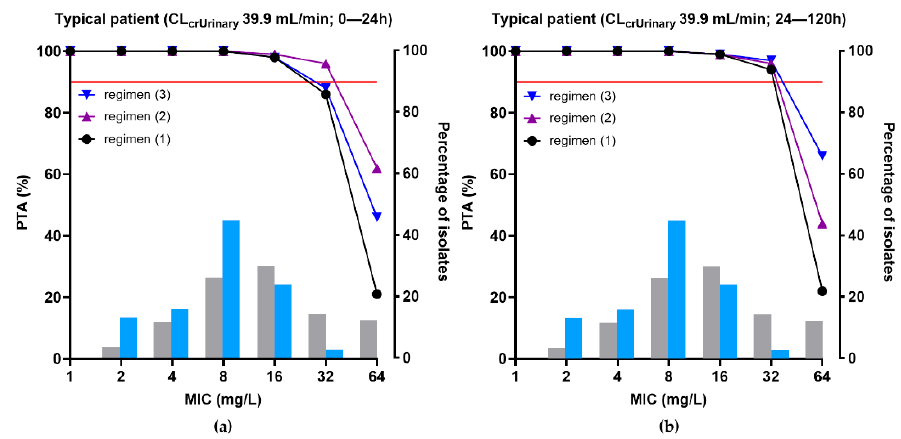
Figure 4. PTA of temocillin in plasma for typical septic patients (Median CL CRurinary = 39.9 mL/min)